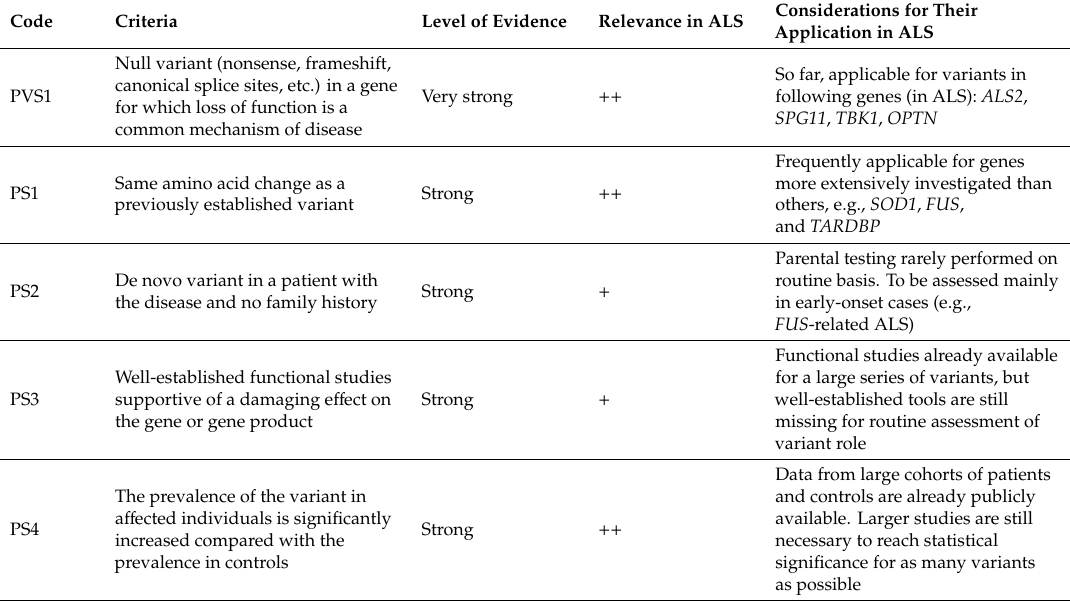
Table 1. List of the American College of Medical Genetics and Genomics (ACMG) criteria, with their acronyms, relevance in amyotrophic lateral sclerosis (ALS), and considerations about their application in ALS variant